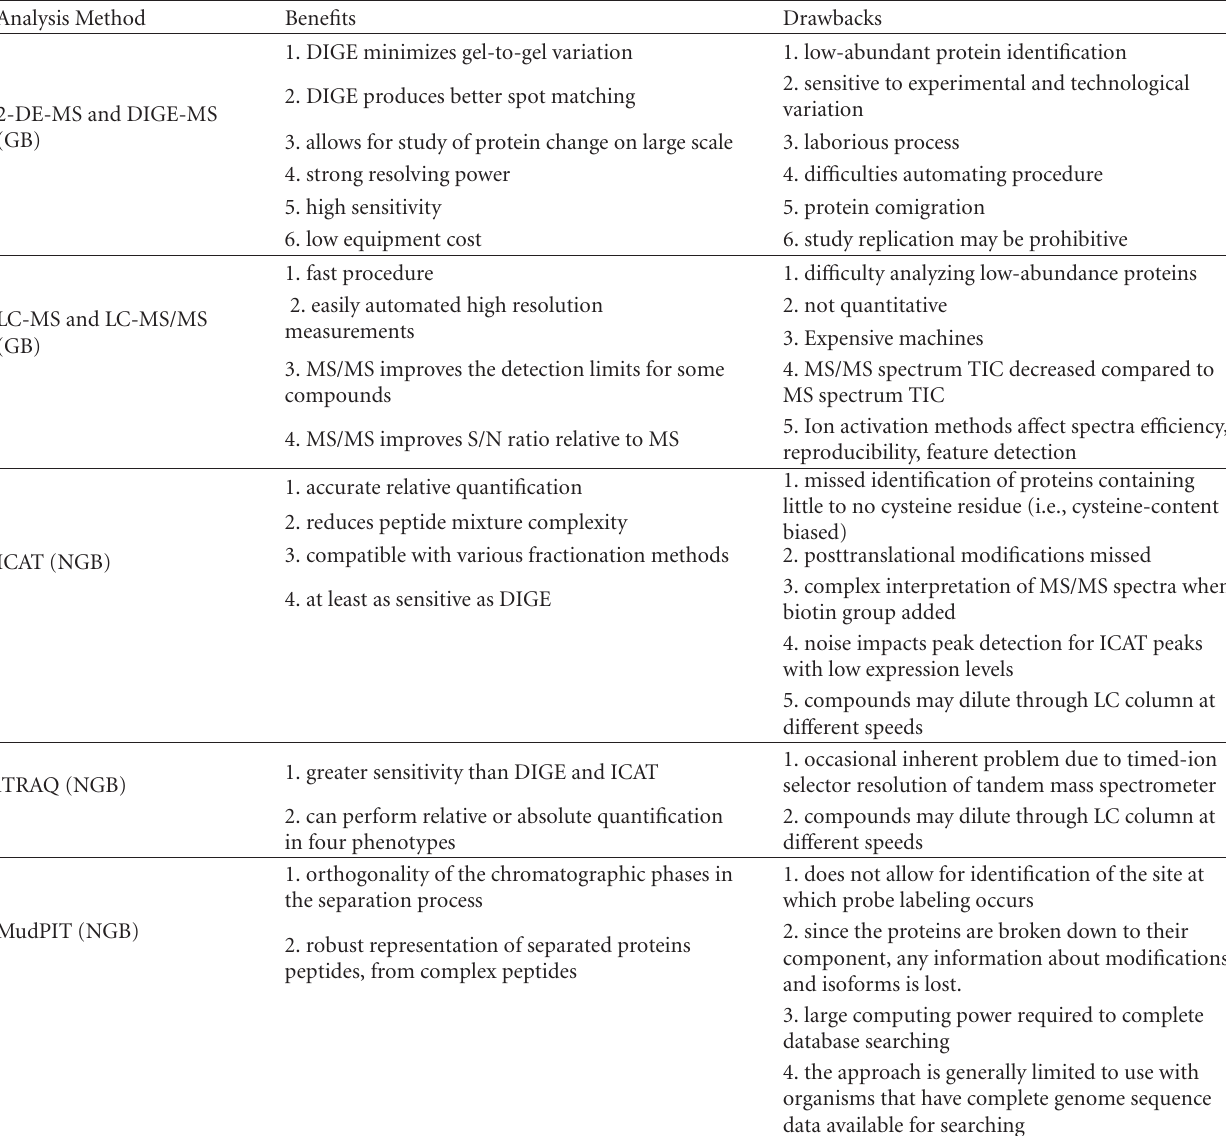
Table 1: Comparison table of gel-based and non-gel-based methods for proteomic data analysis. This table highlights some benefits and drawbacks to many popular technological approaches in analyzing protein samples. GB and NGB, respectively, denote the associated technique as gel-based or